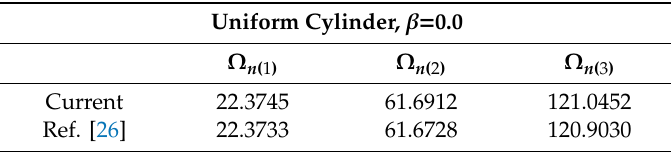
Table 1. Frequency parameters of a uniform beam with circular cross-section with free-free boundary conditions.